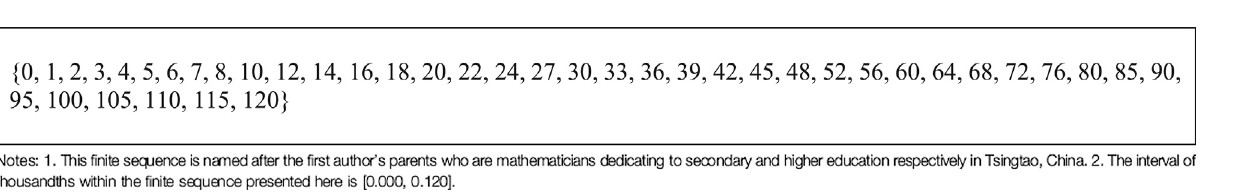
Box 1 | The Chunrong – Minggao sequence of thousandths.